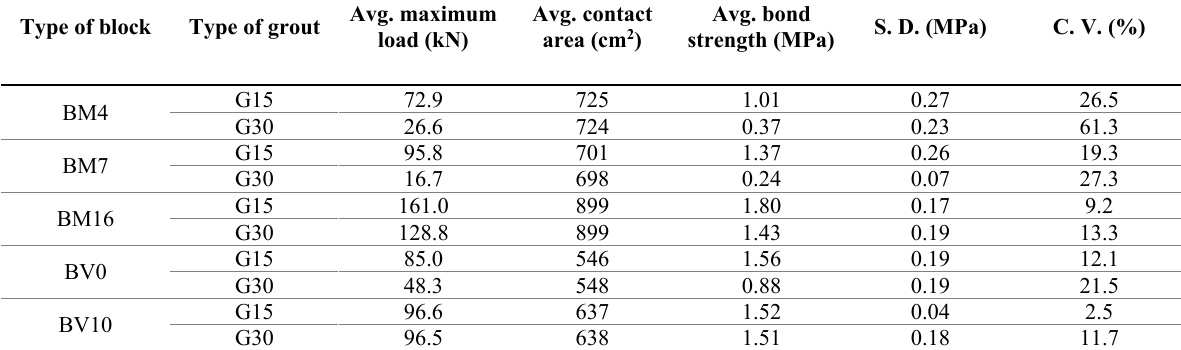
Table 4. Results of the push-out